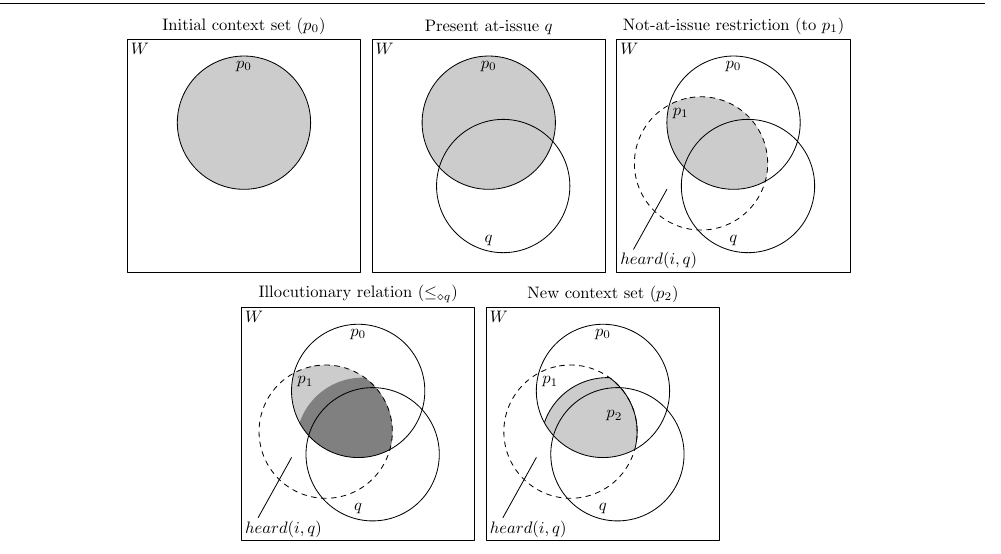
Figure 5 Updates for ( 20 ): English evidential